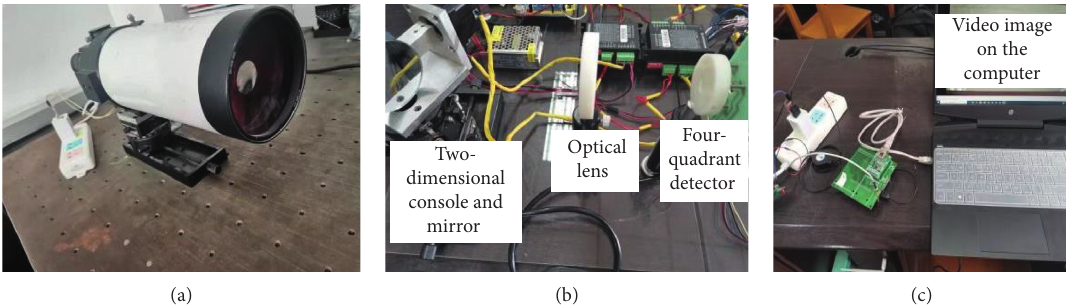
Figure 5: Indoor experiment of airborne laser communication. (a) Transmitter. (b) Airborne control receiver. (c) Communication receiver.